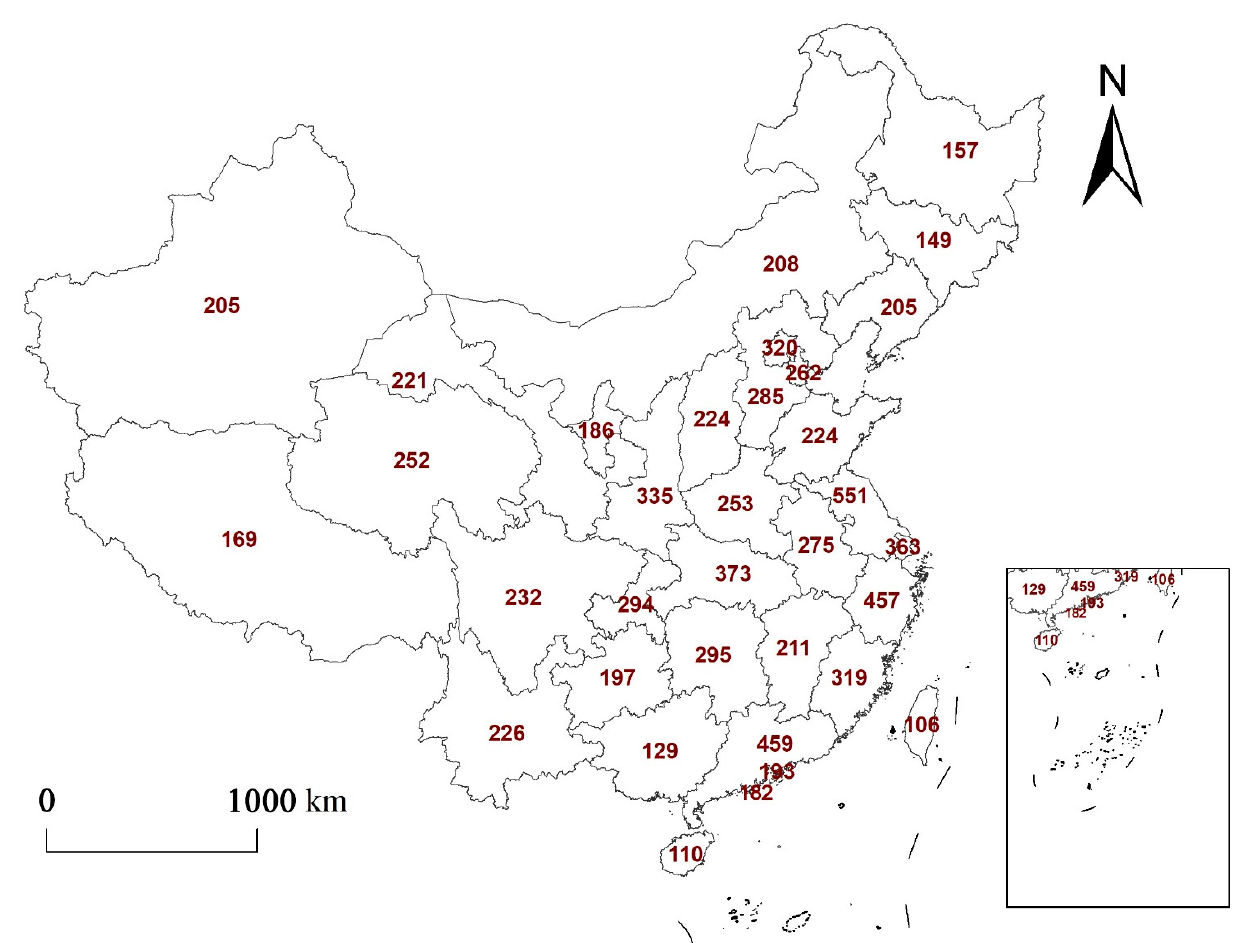
Figure 6. Distribution of studies on ecosystem services. The numbers in the figure are the number of ecosystem services studies in each region.